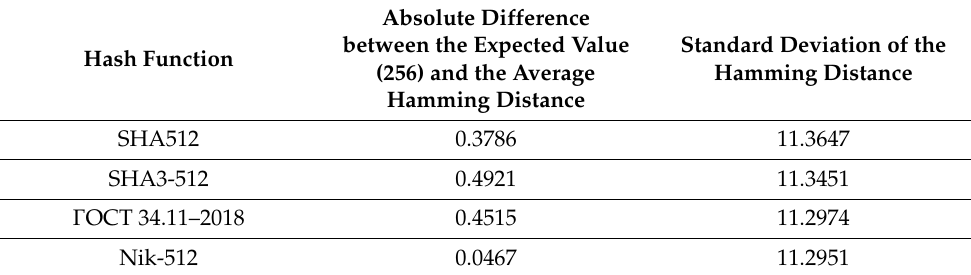
Table 1. The avalanche effect testing